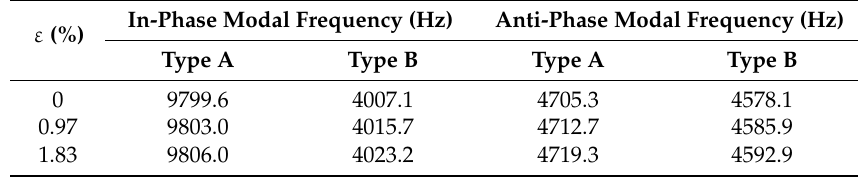
Table 2. In-phase and anti-phase modal frequencies of all designed